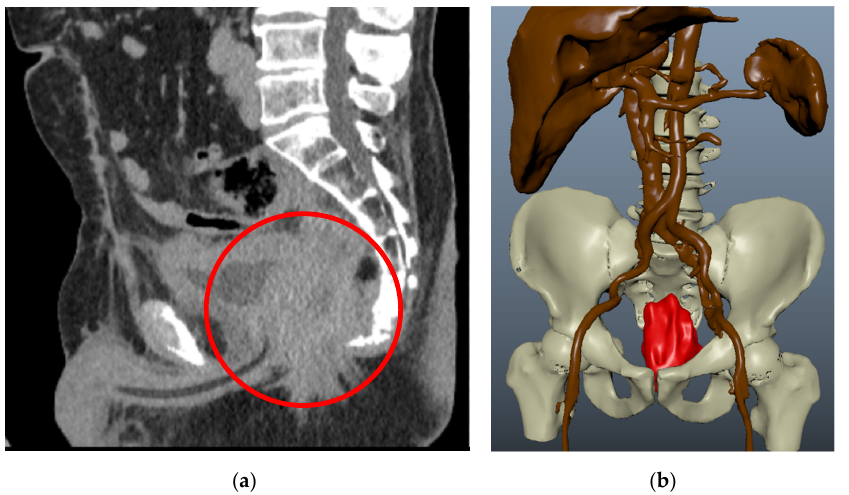
Figure 3. ( а ) CT scan of the pelvis with intravenous enhancement. Tumor size 50 × 71 × 71 mm, with signs of spread to the lower parts of the ureters, the wall of the bladder, and the coccygeal vertebrae (highlighted in a circle); ( b ) 3D model of pelvic organs and vessels. Implanted pin at the right side.